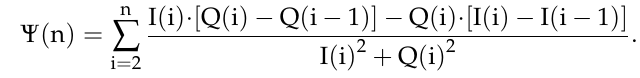
( b ) Figure 5. Phase difference: ( a ) in the time domain; ( b ) in the frequency domain. 2.2.4. Iterative VMD Wavelet-Interval-Thresholding Iterative VMD Wavelet-Interval-Thresholding is mainly used to remove the impulse noise generated after the phase difference operation. This process refers to the EMD-CIIT described in paper [17]. Compared with the empirical mode decomposition (EMD) algo- rithm, the variational mode decomposition (VMD) algorithm also decomposes the origi- nal signal into a series of signal components, which is called the intrinsic mode function (IMF). However, the latter is supported by sufficient mathematical theory [18]. Further- more, the defect of modal aliasing is avoided by decomposing the signal into a certain number of discrete signal components, in which each IMF has different center frequencies and limited bandwidth. Assuming that VMD decomposes the signal into K IMFs, the kth IMF is recorded as 𝑢 (cid:3038) (𝑡) , and its center frequency is ω (cid:2921) ; the goal of the algorithm is to minimize the sum of the estimated bandwidth of each mode, that is: min (cid:4668)(cid:3048) (cid:3286) (cid:4669),(cid:4668)(cid:2985) (cid:3169) (cid:4669) (cid:3421)(cid:3533) (cid:4709)−jω (cid:2921) (cid:3428)(cid:3436)δ(t) + j πt(cid:3440) ∗ 𝑢 (cid:3038) (𝑡)(cid:3432) (cid:4593) e (cid:2879)(cid:2920)(cid:2985) (cid:3169) (cid:2930) (cid:4709) (cid:2870)(cid:2870)(cid:2895) (cid:2921)(cid:2880)(cid:2869) (cid:3425), (5) where (cid:4668)𝑢 (cid:3038) (cid:4669) means (cid:4668)𝑢 (cid:2869) , … , 𝑢 (cid:3012) (cid:4669) and (cid:4668)ω (cid:2921) (cid:4669) means (cid:4668)ω (cid:2869) , … , ω (cid:2895) (cid:4669) . In order to solve this con- strained variational problem, the quadratic penalty term α and Lagrangian multiplier 𝜆(𝑡) are introduced, which can transform the problem into an unconstrained variational problem as follows: